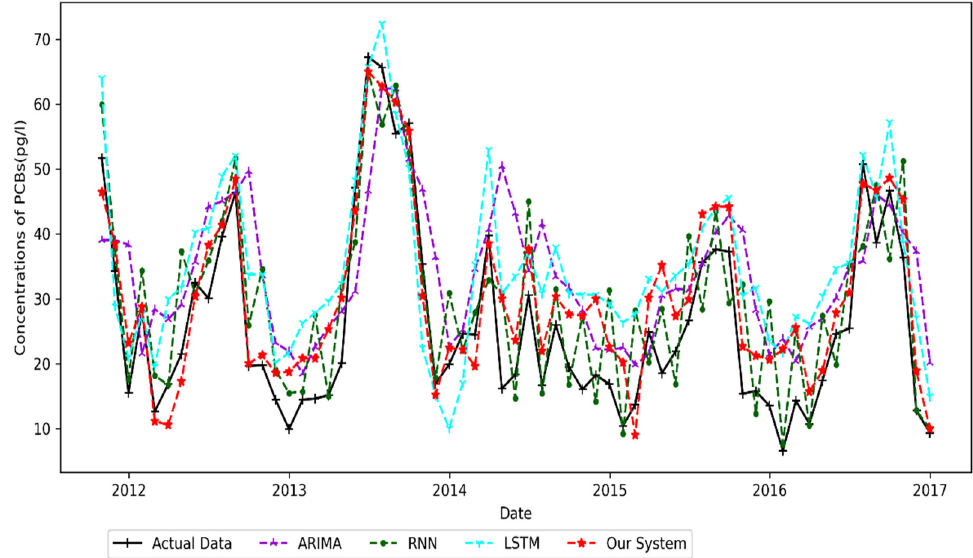
Figure 8. Prediction results of each model on Eagle Harbor dataset.